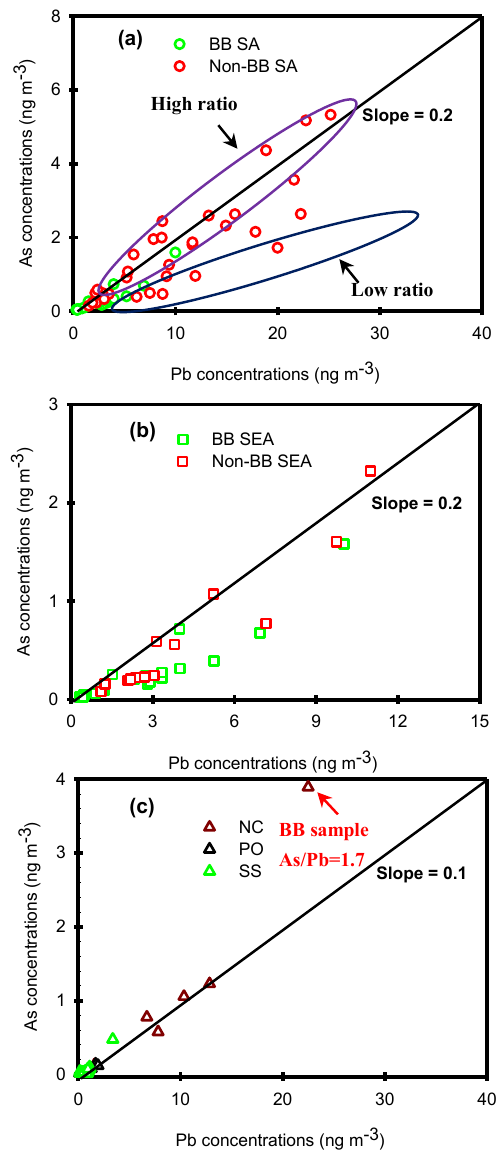
Figure 9. Scattered plots of As against Pb observed at Mount Hehuan in (a) SA, (b) SEA, and (c) other air groups during the S and SE Asian biomass burning